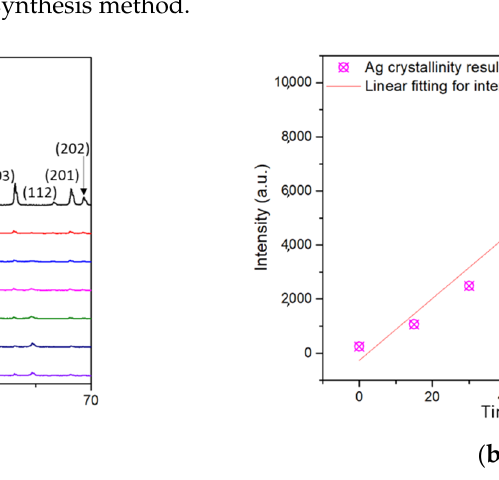
Figure 1. ( a ) XRD results for ZnO-ITO and Ag@ZnO-ITO at various irradiation times, and ( b ) the intensity variation of the peak at 2 θ = 38.01°.